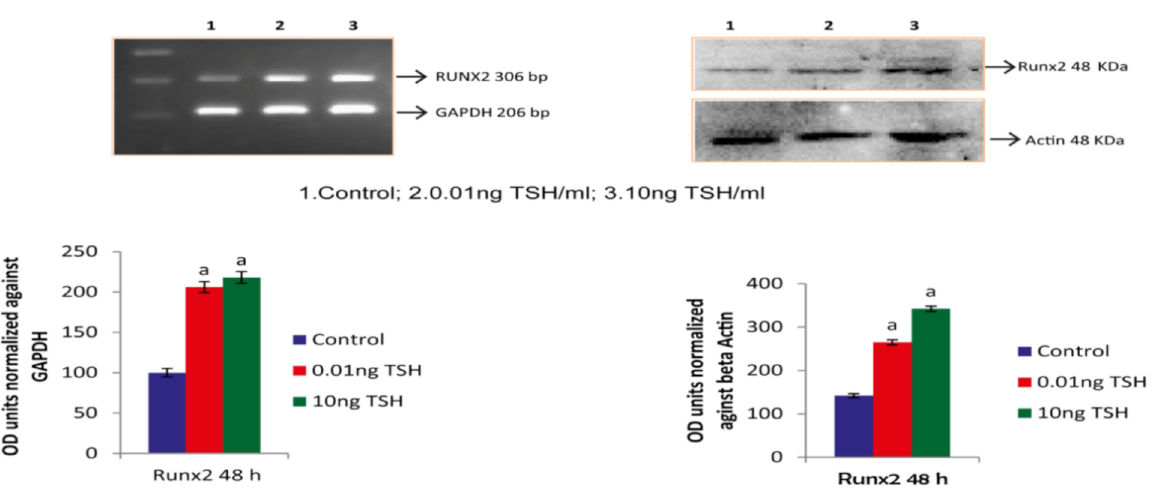
Figure 1. TSH influences Runx2 expression in HOS cells. Each bar diagram shows mean ± SEM of three experiments; ‘a’ represents compared with control at p < 0.05.